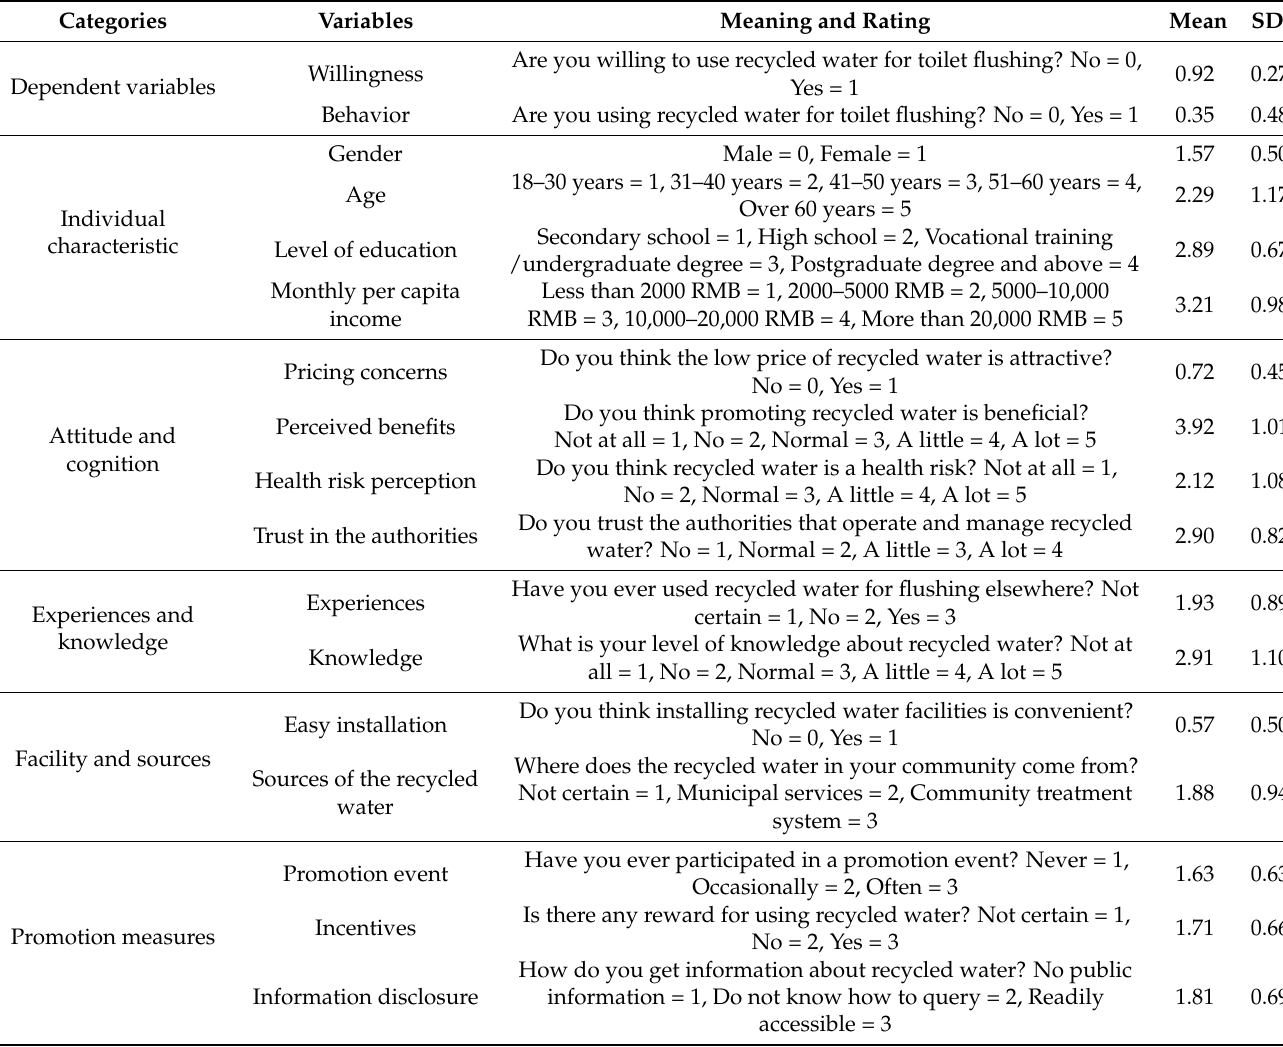
Table 2. Variable definition and results of descriptive